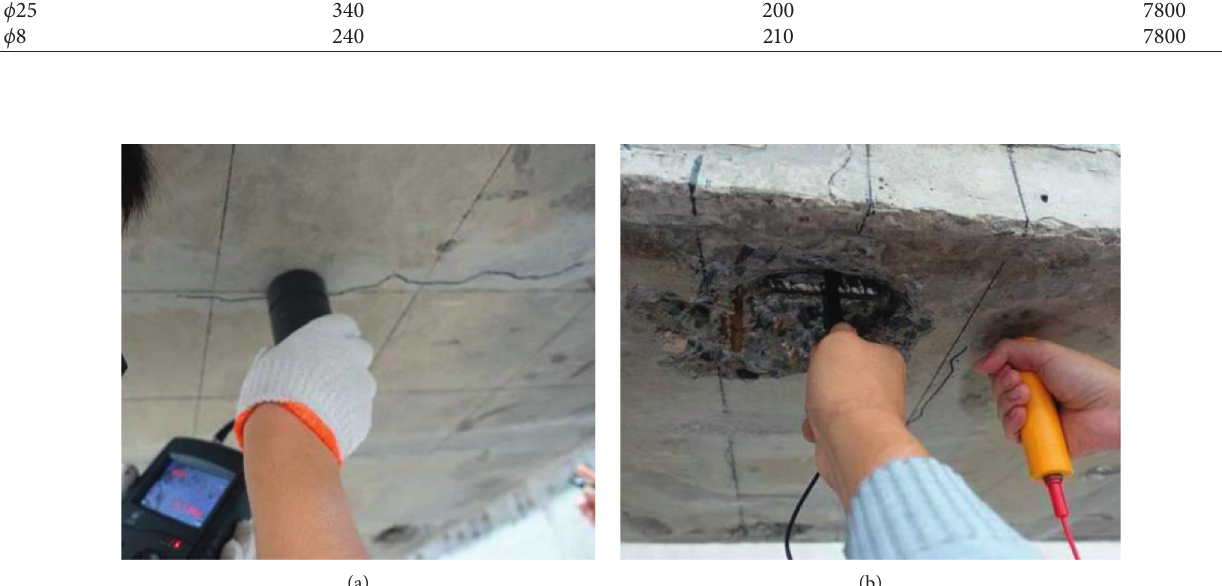
Figure 4: Pretest detection: (a) crack width; (b) corrosion of reinforcement.